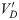
Least squares regression interpretation of VD′.Grey circles indicate the genotypic value of each genotype, which is coded as 0, 2, 2 for aa, Aa, and AA respectively. A regression line (red line) is fitted to the data, on which the fitted values are indicated by white circles. The fitted line must pass through the center of the data, as indicated by the cross. The fitted line must also pass through the circle (half grey and half white to indicate the overlap of the genotypic and fitted values) denoting genotype aa. The fitted values are equivalent to dominance values as defined in this parameterization. The arrows between the dominance values and the genotypic values are the residuals of the regression, which we define as “additive deviation”, therefore the residual variance is VA′. Note that the data points are weighted by their frequencies in the population. An additive model is used so that the additive deviation can be illustrated.